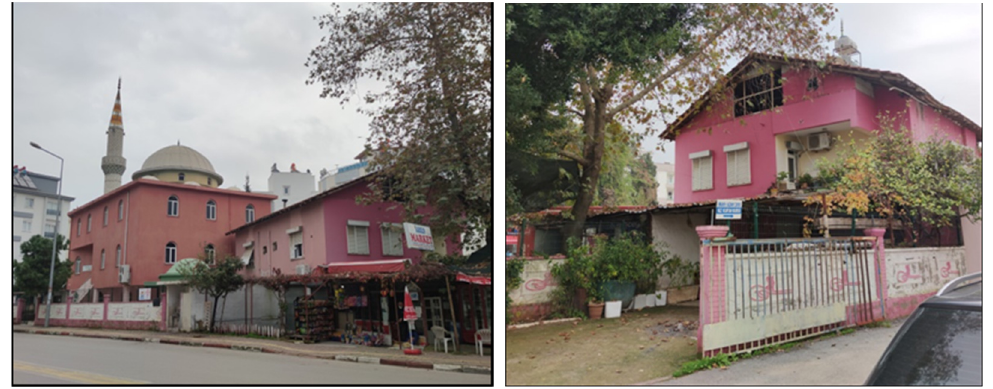
Figure 16. The Imam Azam Mosque and additional buildings.